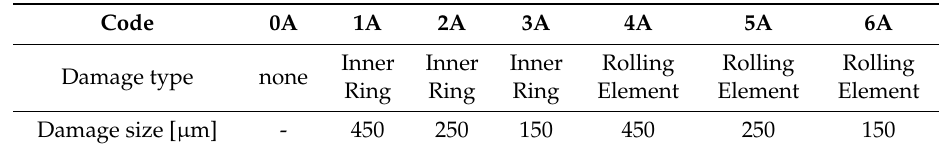
Figure 1. The experimental setup, the triaxial accelerometers location (A1 and A2) and orientation ( a ) Constructive parts; ( b ) Bearings and accelerometers location. Table 3. Bearing B1 codification according to damage type (inner ring or rolling element) and size. The damage is obtained through a Rockwell tool producing a conical indentation of maximum diameter reported as characteristic size.